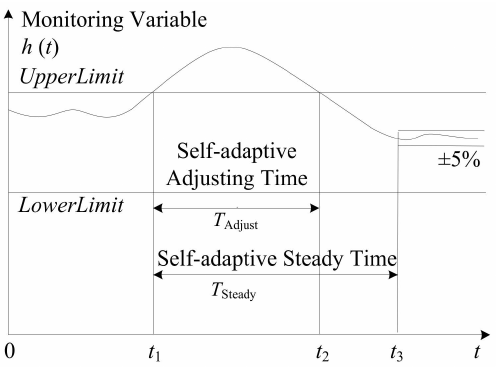
Figure 7. Self-adaptive Adjusting Time and Self-adaptive Steady